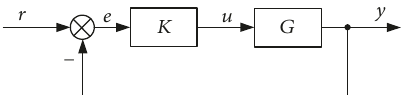
Figure 1: Feedback control system.